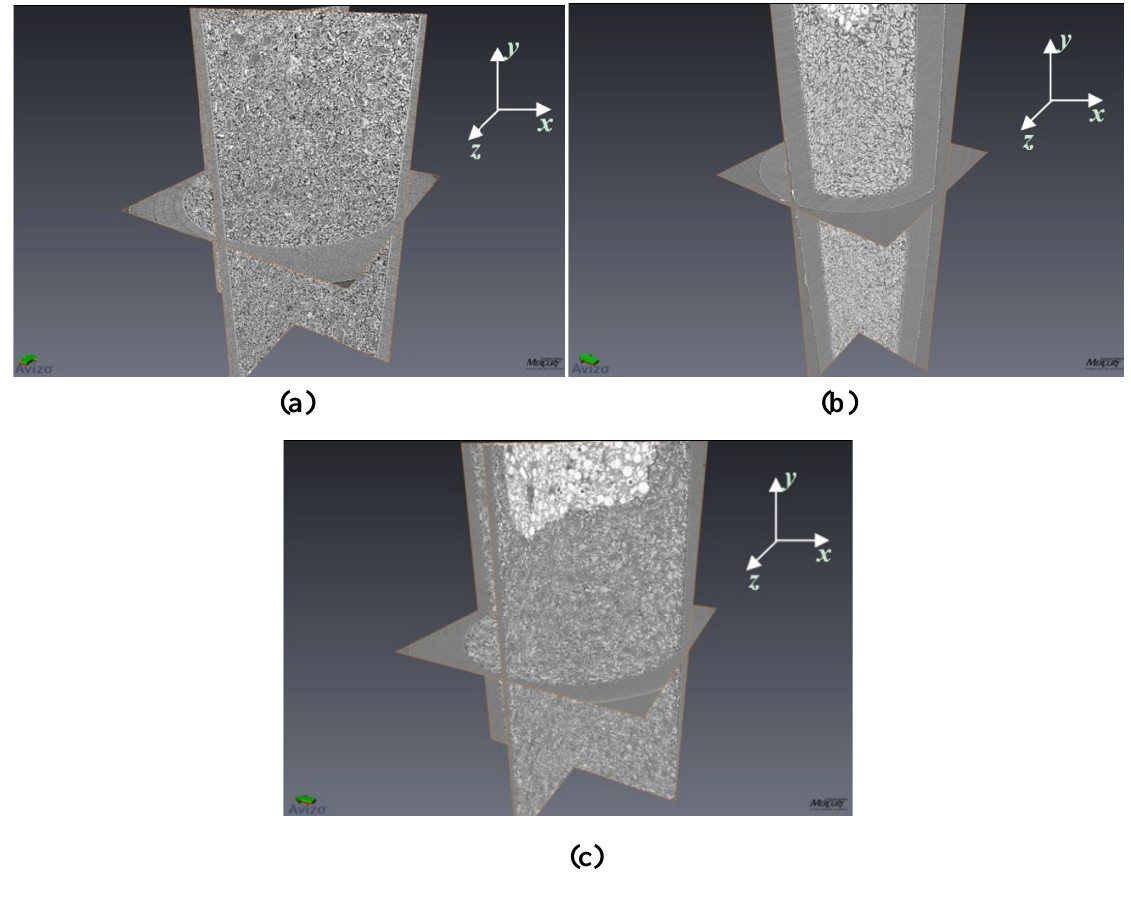
Figure 1. Three dimensional images of ( a ) 4 mol % TiCl TiCl catalyzed MgH 3